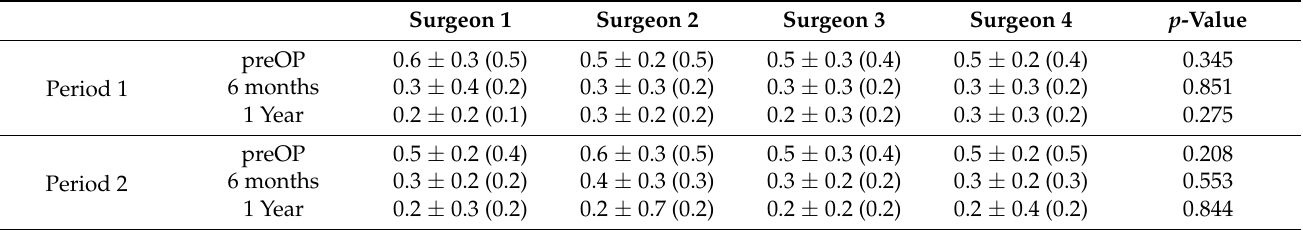
Table 3. Clinical results * after DMEK and Triple-DMEK for each surgeon—CDVA (logMAR). Surgeon